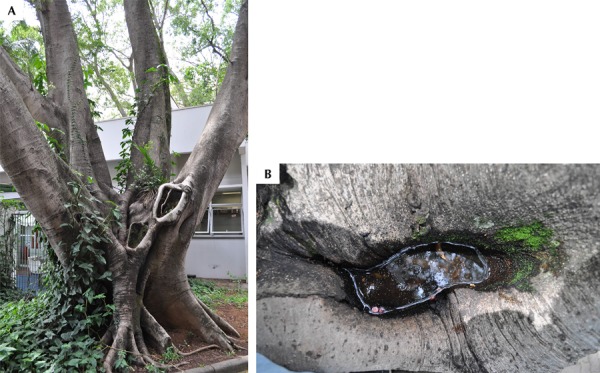
Criadouro natural com larvas de Ae. aegypti. (A) Vista parcial da árvore localizada em jardim no bairro de Pinheiros, onde foram encontradas as nove larvas de Ae. aegypti. (B) Detalhe do oco de árvore onde as larvas foram coletadas.